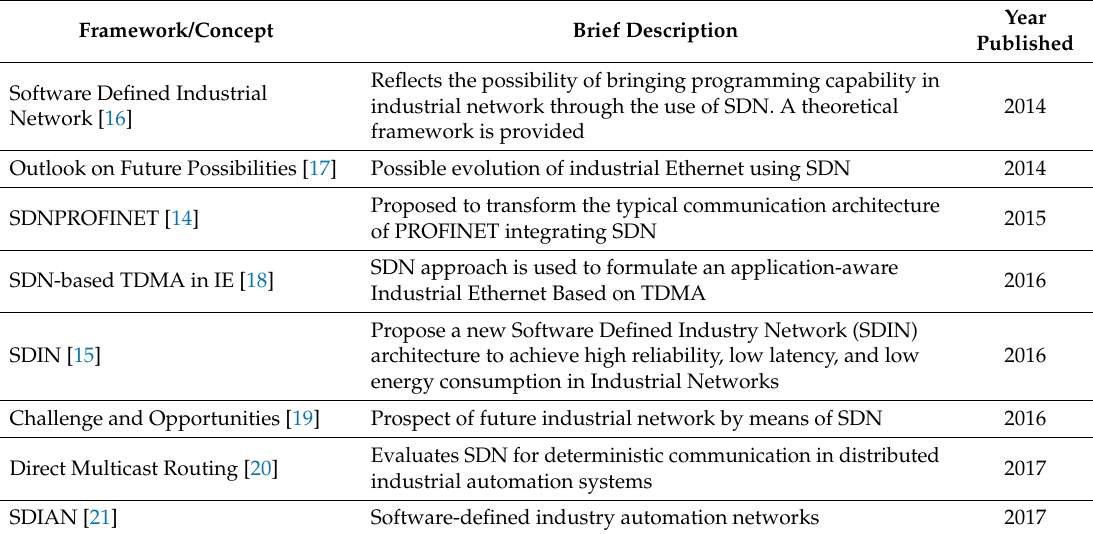
Table 2. Software-Defined Network